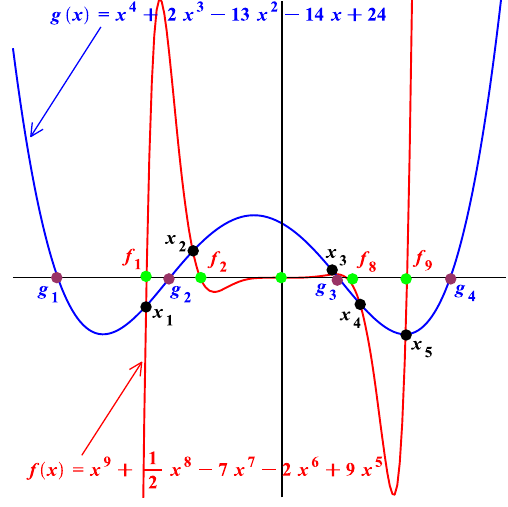
Figure 7: The equation